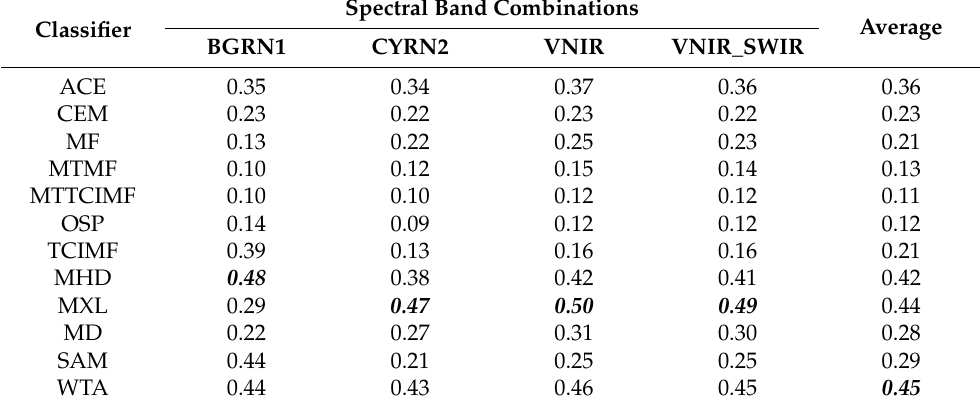
Table 6. Performance of PBIA in the current study averaged across all processing schemes for each subset using the F1 score. The values of the best performing classifiers are highlighted in bold and